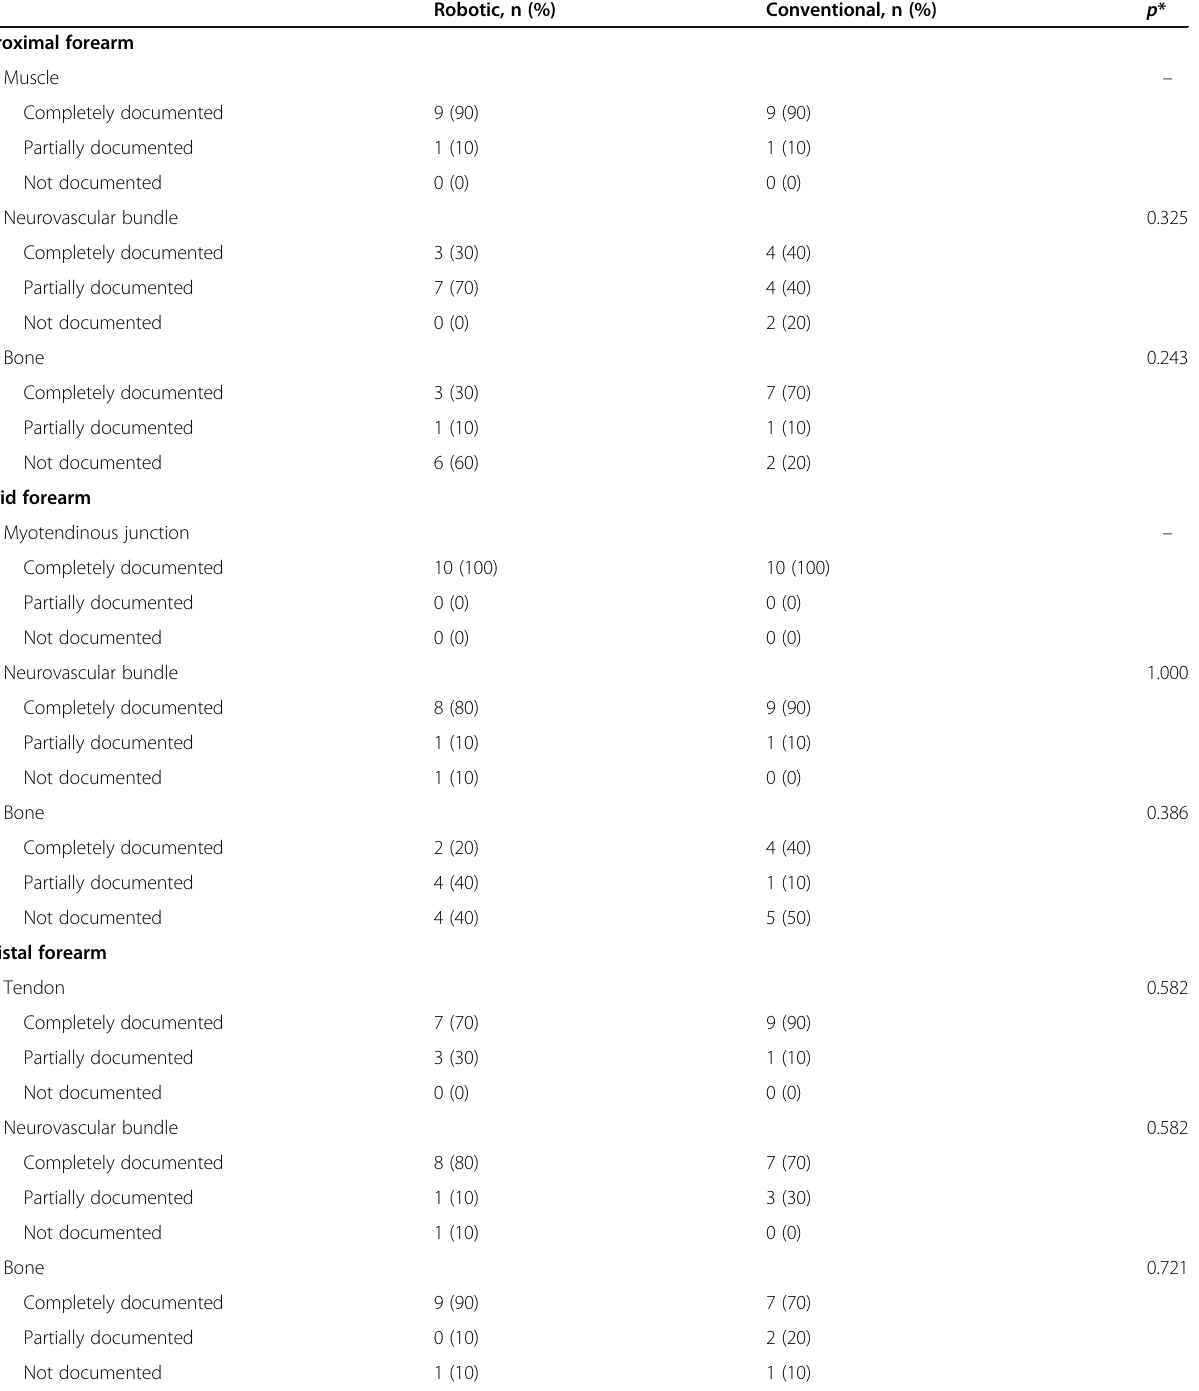
Table 3 Visualisation of anatomic structures on robotic versus . conventional images Robotic, n (%) Conventional, n (%) p